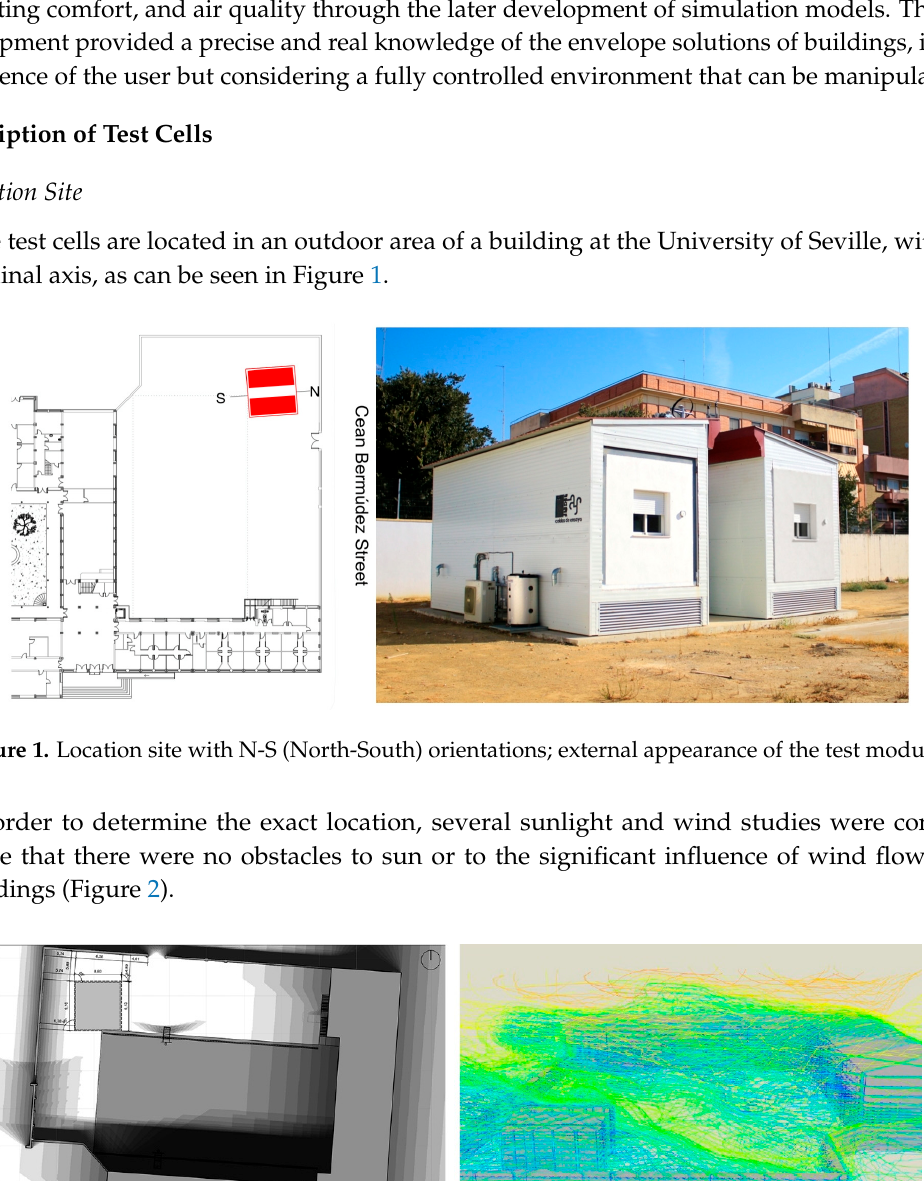
Figure 2. Solar and wind influence study (autumn equinox, 9:00 a.m. to 4:00 p.m.).